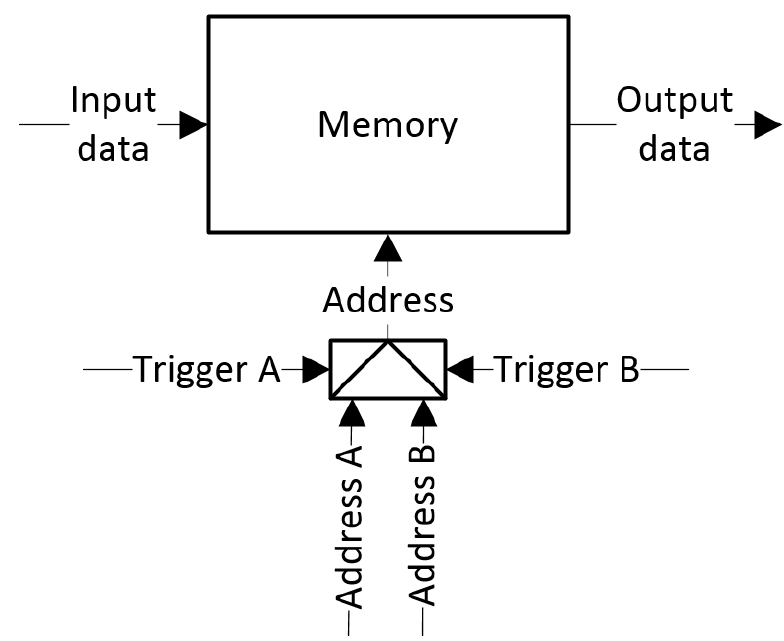
Figure 5. Memory addressing by several control units.